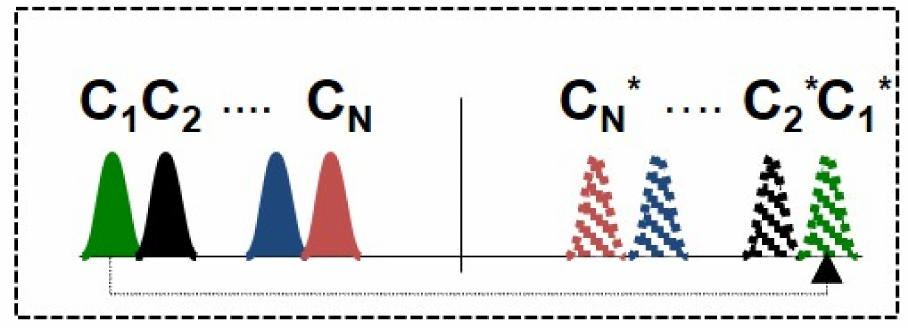
Figure 3. WDM grid of the transmitted ( left ) and the conjugated ( right ) WDM channels in a mid-link OPC system. “*” denotes conjugated